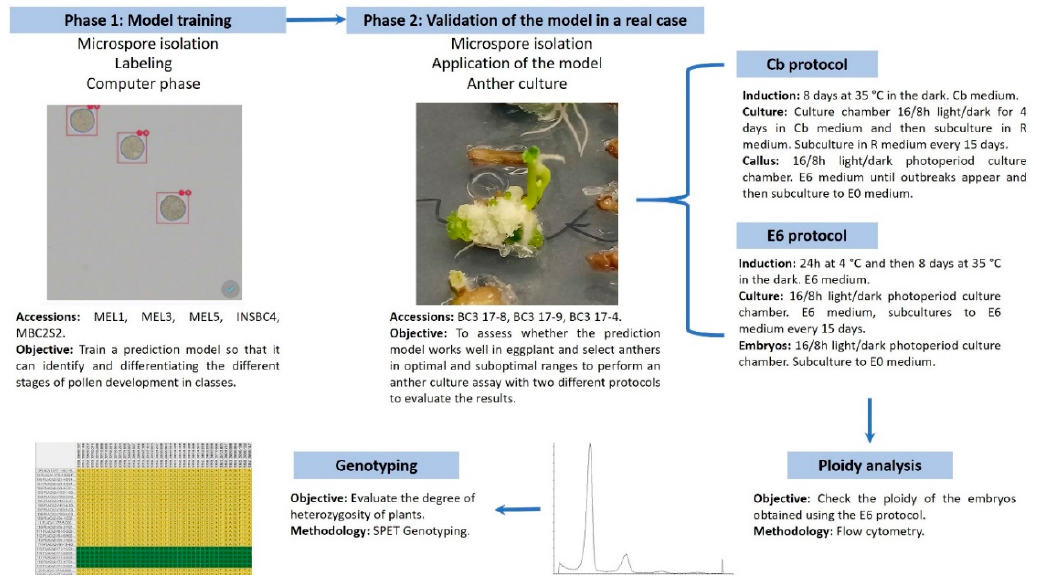
Figure 1 . Description of the experimental design and the main objectives. The flow of the arrows indicates the order in which the experiments were conducted and their relationships.